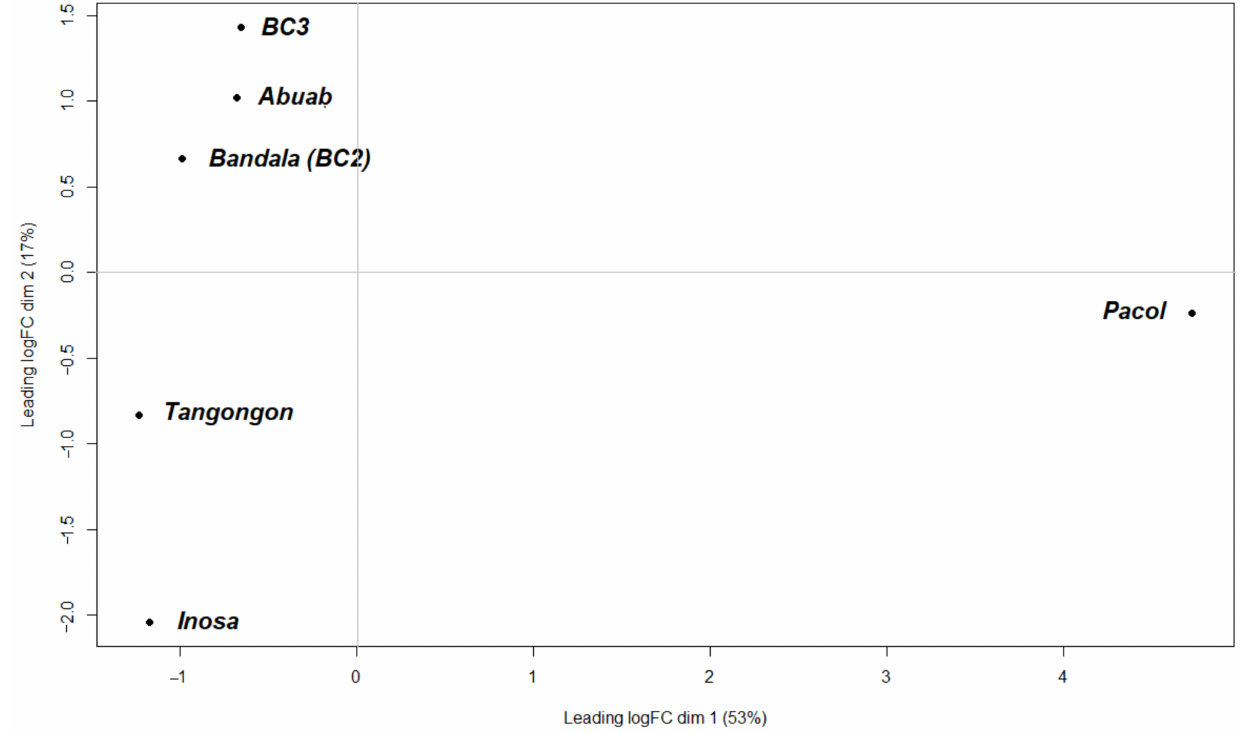
Figure 2. MDS plot of the six Musa sp. using normalized RNA-seq data counts.